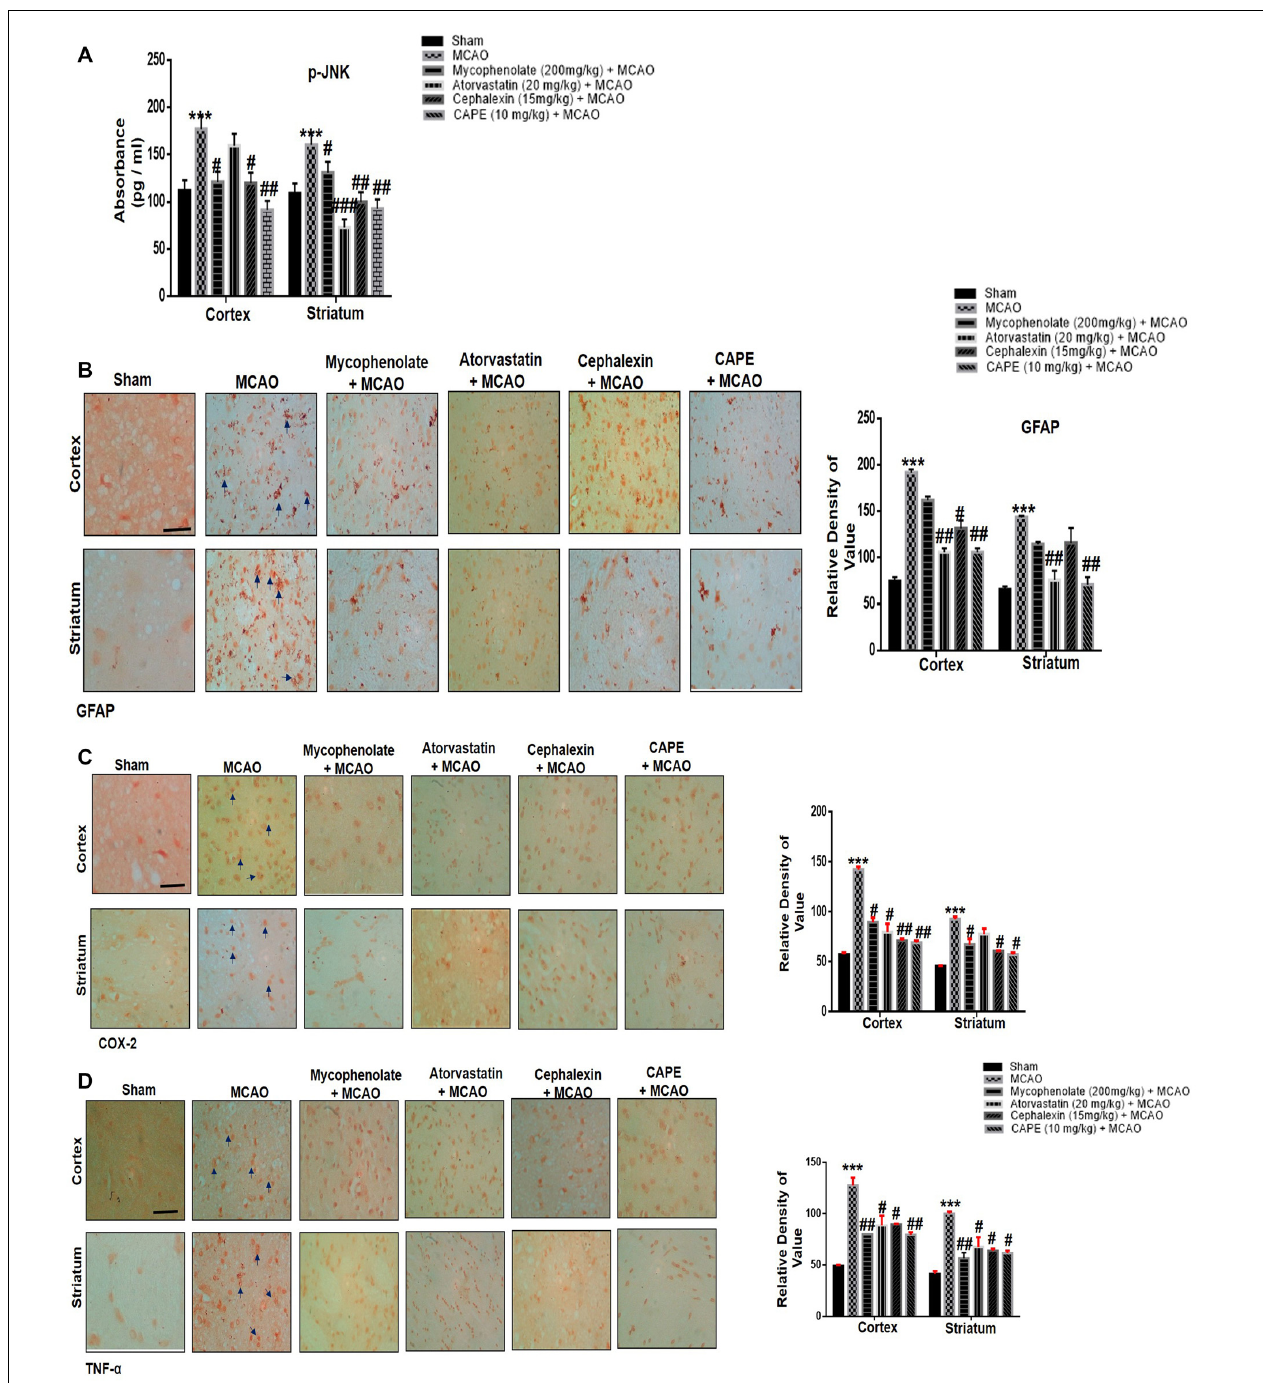
FIGURE 6 | Effect of test drugs on the inflammatory cascade. Effect of atorvastatin, cephalexin, mycophenolate, and CAPE on inflammatory markers. (A) Elisa analysis of p -JNK. The data are expressed as the Mean ± SEM. *** p < 0.001 relative to sham while ## or # show respectively p < 0.01 or p < 0.05 relative to MCAO, with n = 5/group, After euthanasia, brain tissues were collected and preserved at -80 ◦ C and later processed for protein analysis. The p -JNK was significantly expressed in the MCAO group relative to sham, while treatment with test drugs attenuated the MCAO induced hyperexpression of JNK in cortex and striatum. (B) Immunohistochemistry results for astrocytes (GFAP) in the cortex and striatum tissues of the brain (C) Immunohistochemistry of COX2 in the cortex and striatum tissues of the brain and (D) Immunohistochemistry of TNF- α in the cortex and striatum tissues of the brain. Immunoslides were processed from stained TTC coronal sections. From the thick coronal TTC sections, paraffin blocks were made and later 4 µ m thin coronal sections were prepared by a rotary